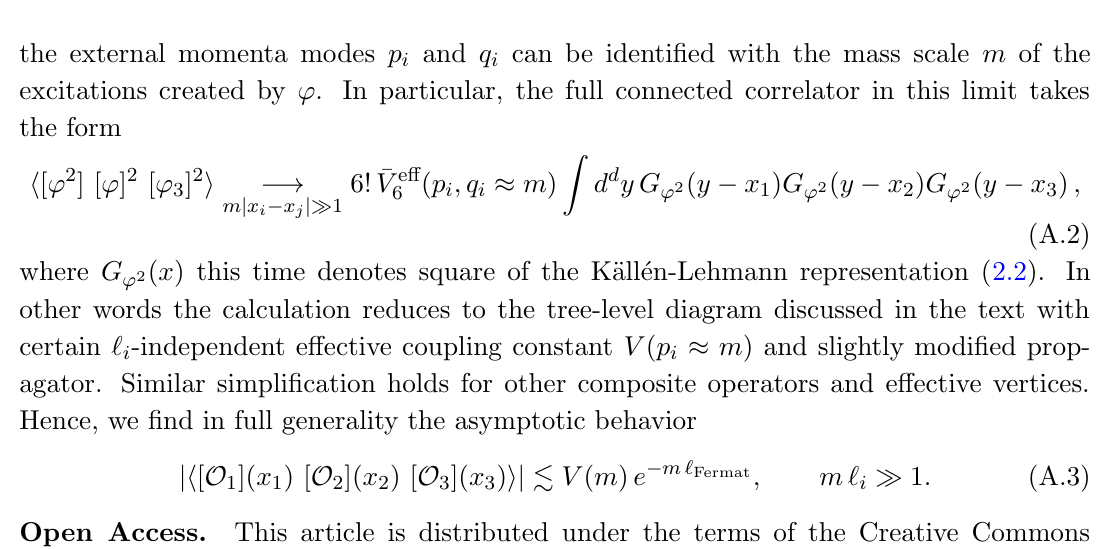
Figure 7. Two skeleton diagrams built out of the e(cid:11)ective action vertices V 3 and V 4 with 3 and 4 external legs